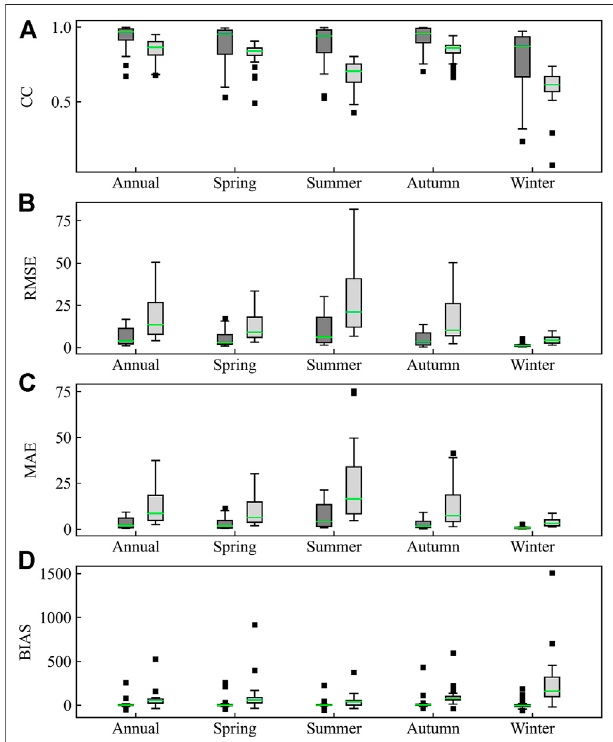
FIGURE 5 | Boxplots of the statistical metrics [CC (A) , RMSE (B) , MAE (C) , and BIAS (D) ]for CMFD and ERA5-Landmonthlyprecipitationagainst 28 observation stations data. Five lines from bottom to top for one box represent minimum value, 25th percentile, 50th percentile, 75th percentile, and maximum value, respectively. The blackspot inside the box represents the mean